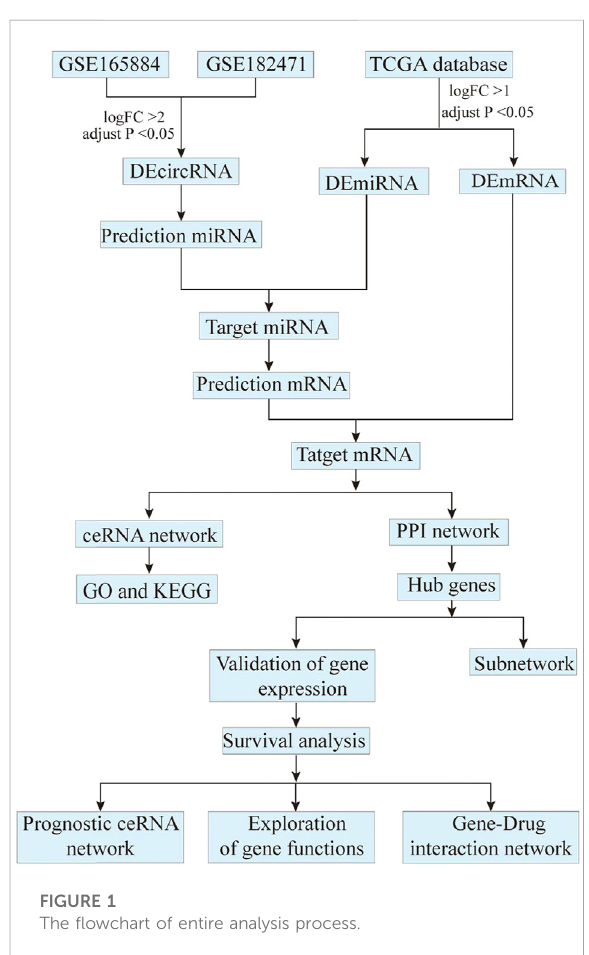
FIGURE 1 The fl owchart of entire analysis